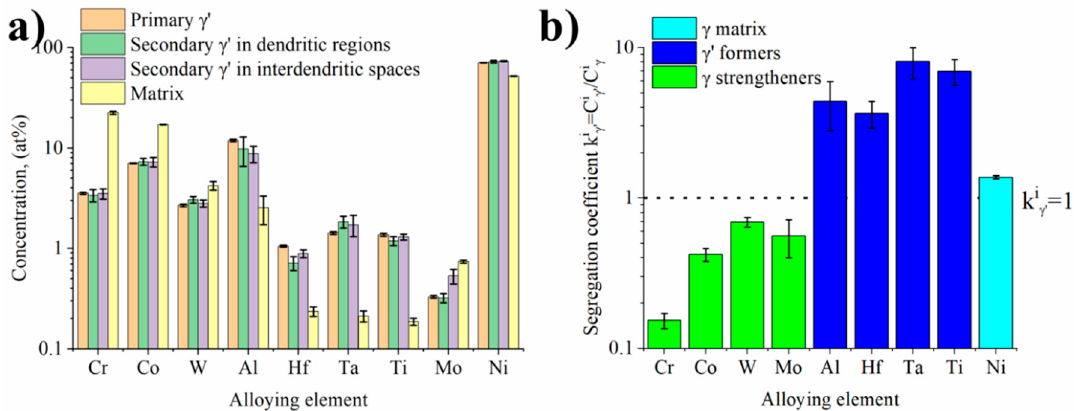
Figure 7. Results of quantitative STEM ‐ EDX analysis of γ ' precipitates and γ matrix: ( a ) chemical composition of the γ ' precipitates and γ matrix; ( b ) segregation coefficient k i γ ' : the calculation based on the concentration of alloying elements.